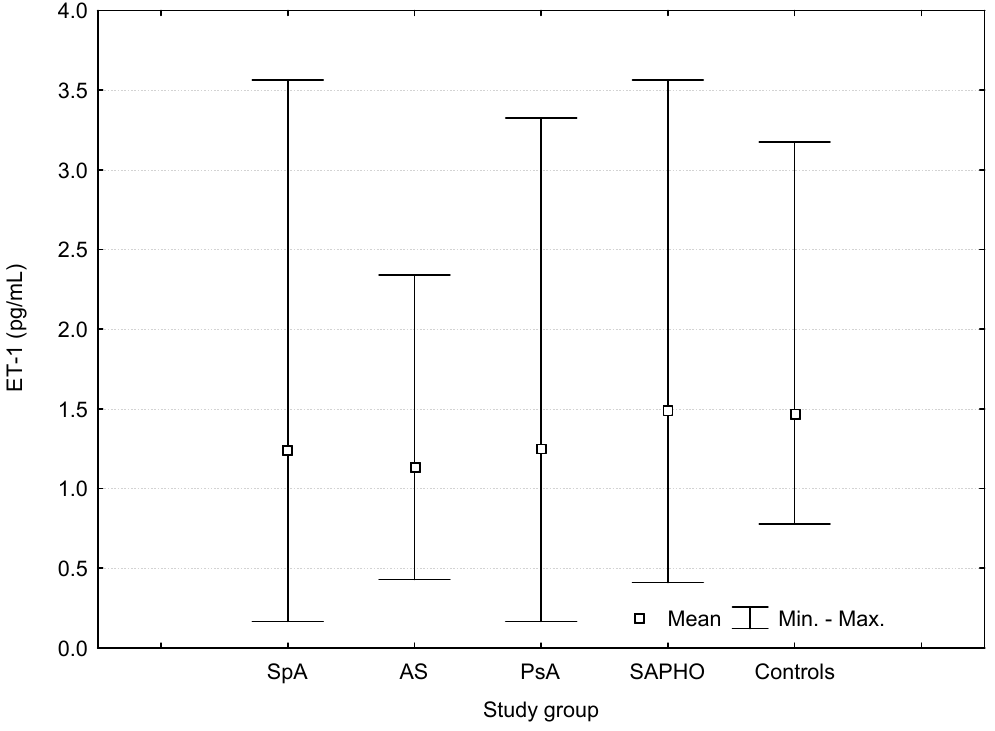
Figure 3. Serum concentrations of endothelin-1 (ET-1) in patients with spondyloarthritis (SpA), ankylosing spondylitis (AS), psoriatic arthritis (PsA), SAPHO syndrome (SAPHO), and controls. Serum ET-1 levels were lower in AS than in SAPHO patients ( p = 0.0003), and in PsA than in SAPHO patients ( p = 0.05, Table 2). No differences were found between female and male patients in terms of serum ET-1 levels in SpA patients and in controls (all p > 0.05).